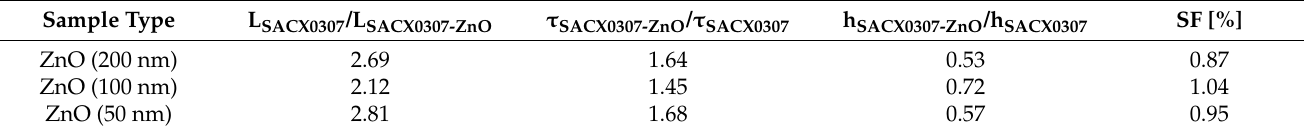
Table 1. Influential factors on the shear